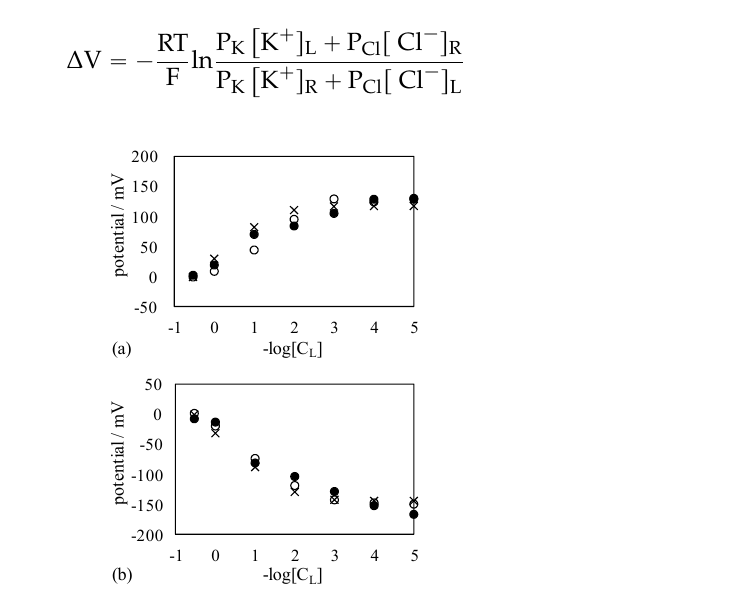
Figure 10. ( a ) Membrane potential shown in Figures 5a ( ○ mark) and 7a ( ● mark) and the computed membrane potential based on the GHK equation assuming P K = 1 and P Cl = 0.008 (× mark); ( b ) Membrane potential shown in Figures 5b ( ○ mark) and 7b ( ● mark) and the computed membrane potential based on the GHK equation assuming P K = 0.008 and P Cl = 1 ( ˆ